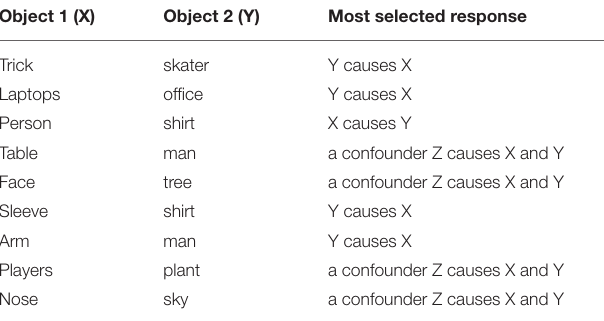
TABLE 2 | Subset of response pairs from